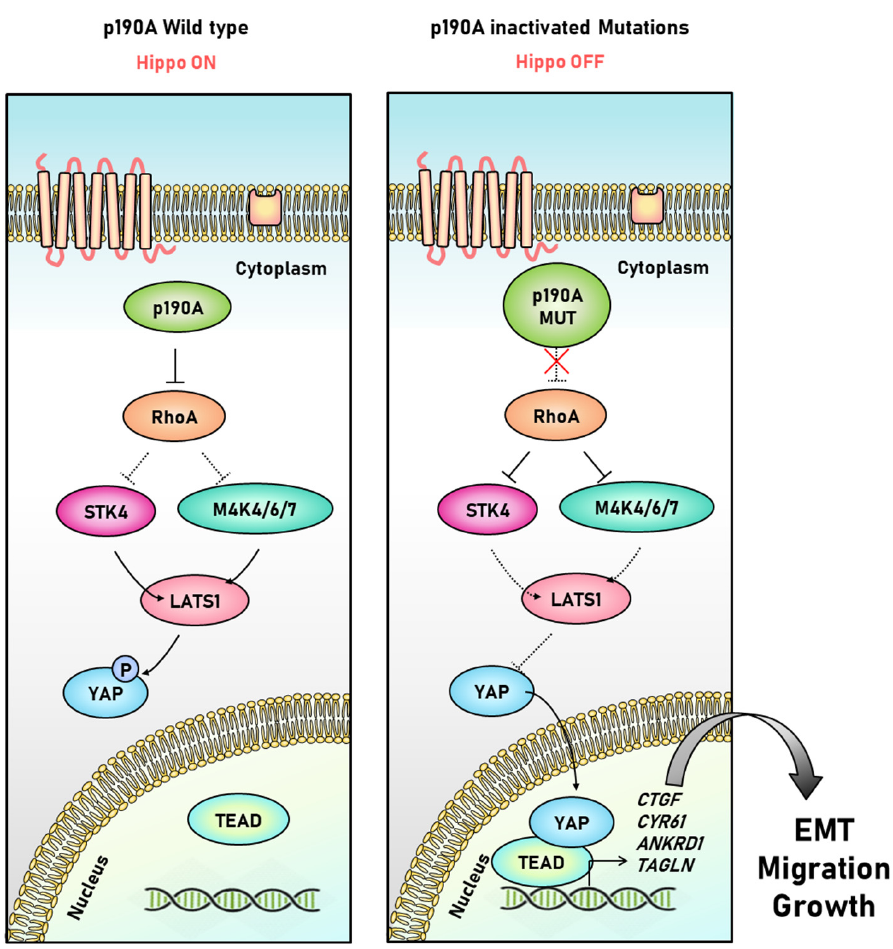
Figure 3. Interaction between P190A and Hippo signaling pathway in endometrial cancer cells. Under normal conditions, P190A induces YAP phosphorylation by crossing the Hippo signaling pathway through RhoA inhibition. When P190A is mutated, RhoA is abnormally activated, interfering with the activity of STK4 and MAP4K4/6/7, preventing the phosphorylation of LATS1/2, and triggering the transcriptional activation of YAP, resulting in the transcription of EMT-related target genes [81].